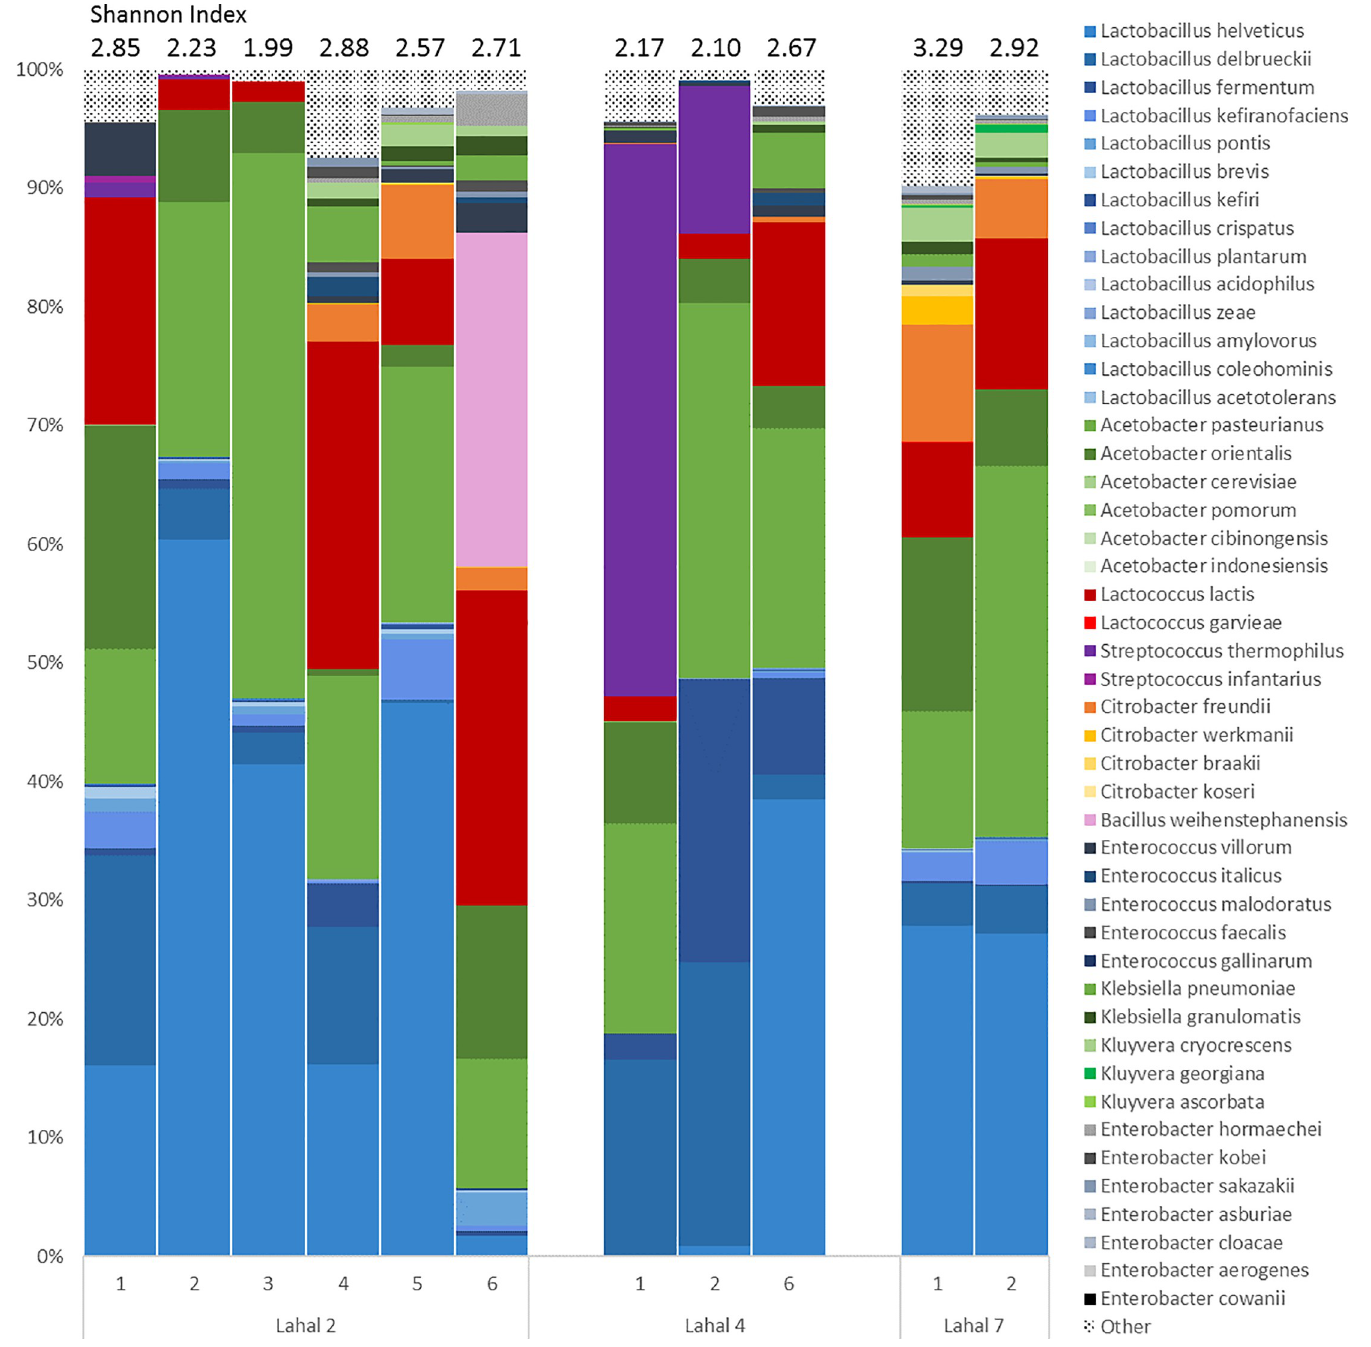
Fig 3. Community composition of bacterial species in lait caille´ of lahals 2, 4, nd 7 over time. These lahals were used for fermentation by only adding sterile milk. Data points of lahal 4 and 7 are not shown as there were other ingredients added in these fermentation. Different colors indicate different species and can consist of multiple OTUs. Vertical axes indicates percentage of total reads within the sample. The aim of the figure is to show the diversity found in the microbial communities of lait caille´ in terms of genus and species variation. For specific abundances of species and OTU, please refer to the sequencing data provided with this publication.